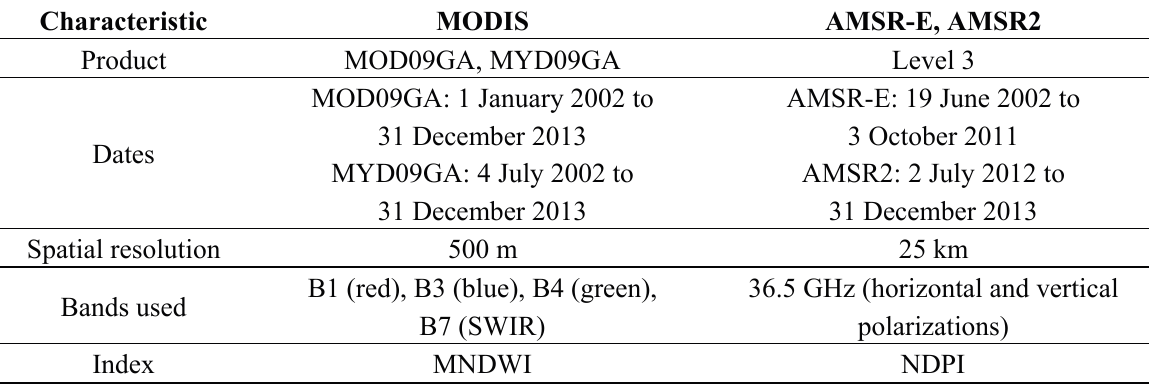
Table 1. Characteristics of the satellite data utilized in this study. SWIR, short-wave